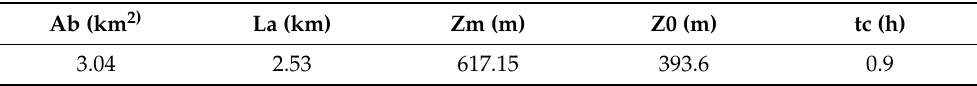
Table 5. Morphometric parameters of the Ciciriello catchment. Ab: watershed area; La: length of the main channel (km); z m = mean height of the watershed (m); z o = height at the outlet (m); and t c = the time of concentration of the